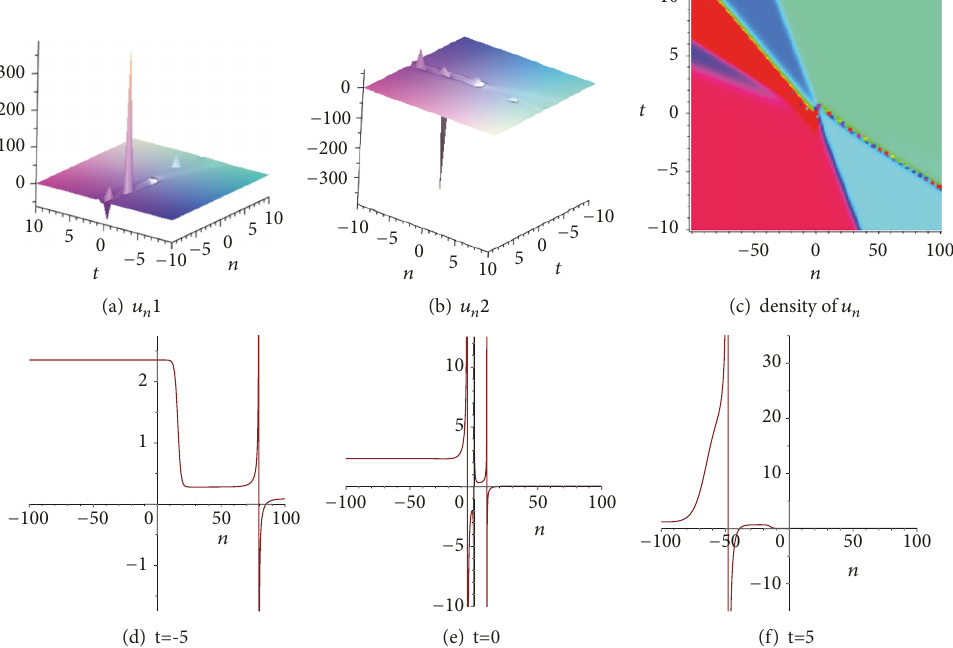
Figure 3: A structure of soliton solution for 𝑢 𝑛 in (68) with 𝜆 1 = 0.5, 𝜆 2 = 2, 𝜆 3 = 1, 𝜆 4 = 4, 𝛾 1 = 1,𝛾 2 = −1, 𝛾 3 = 2,𝛾 4 = −2 . Figures (a) and (b) are three-dimensional graphs of 𝑢 𝑛 , Figure (c) is the density plot of 𝑢 𝑛 , and Figures (d), (e), and (f) are structures of the solution 𝑢 𝑛 at different time.